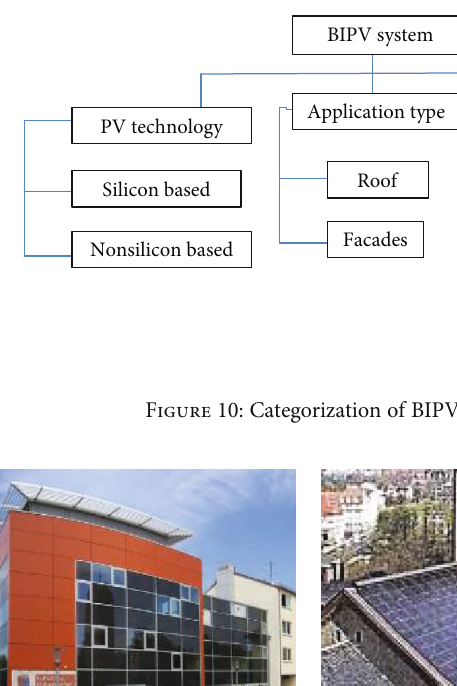
Figure 9: Thin fi lm solar cell